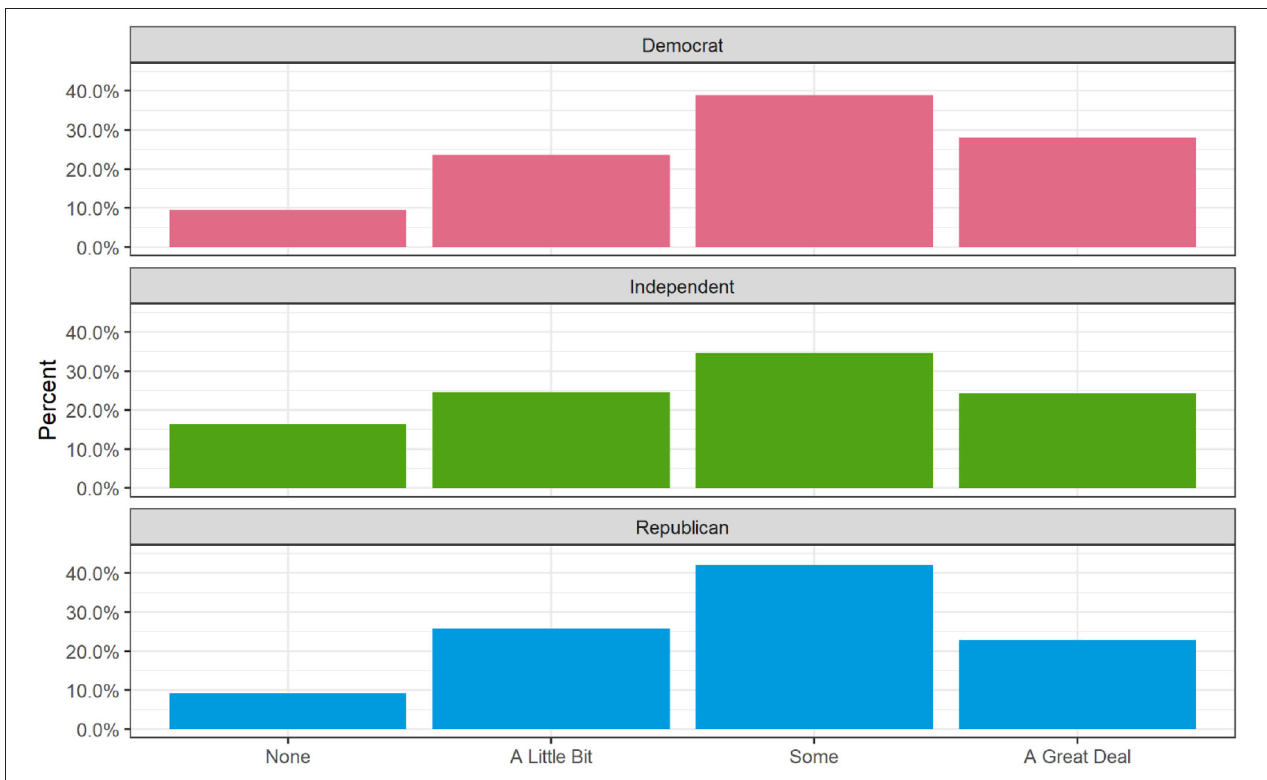
FIGURE 2 | Attention to concussion news by political party